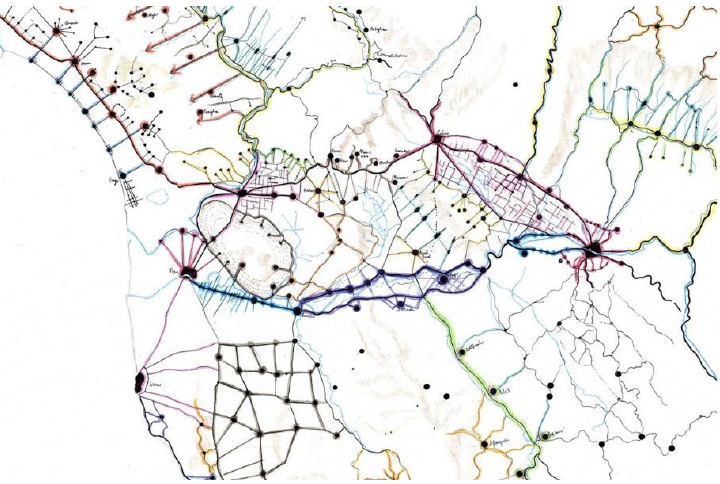
Figure 1. Landscape Plan of Tuscany, settlements’ morphology in and around the lower Arno valley.